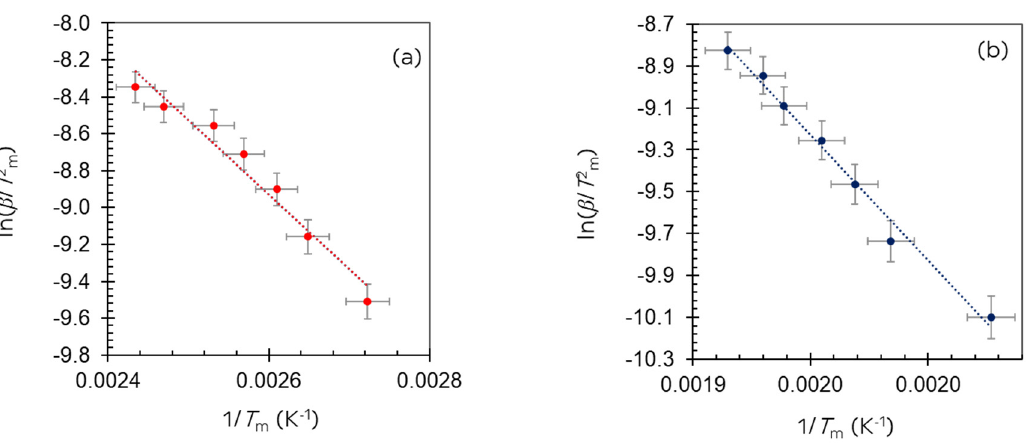
Figure 3. Plots of ln( β / T m 2 ) vs. 1/ T m TPR data points collected from TPR of 3.5 wt.% IrO 2 /TiO 2 (anatase, BET = 55 m 2 /g). The linear regression is ( a ) y = − 4028.9 x + 1.5466, R 2 = 0.96 for the first set peaks, and ( b ) y = − 11976 x + 14.123, R 2 = 0.99 for the second set peaks.